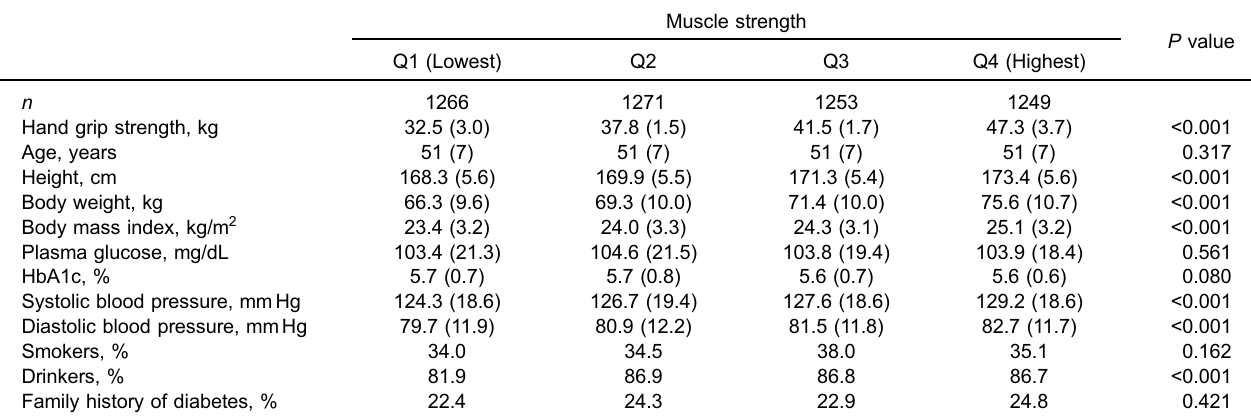
Table 3. Characteristics according to muscle strength categories